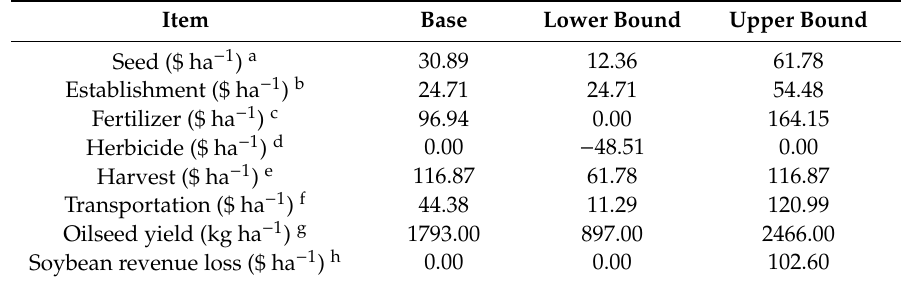
Table 1. Data and assumptions for the breakeven and one-way sensitivity analysis of pennycress oilseed farm-level costs of production and transportation costs from the field to the crushing